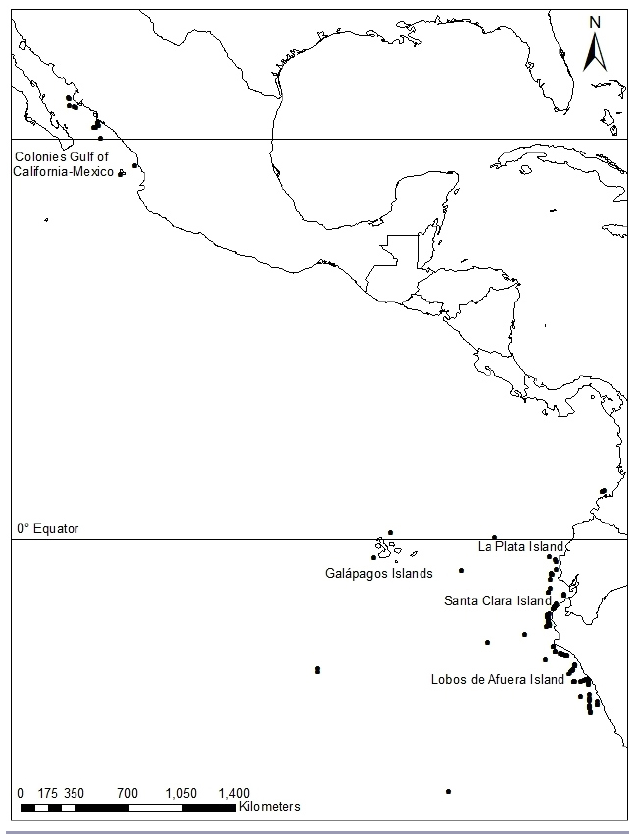
Fig. 4 . Distribution of juvenile Blue-footed Boobies ( Sula nebouxii excisa ) in the eastern tropical Pacific from ship-based surveys,